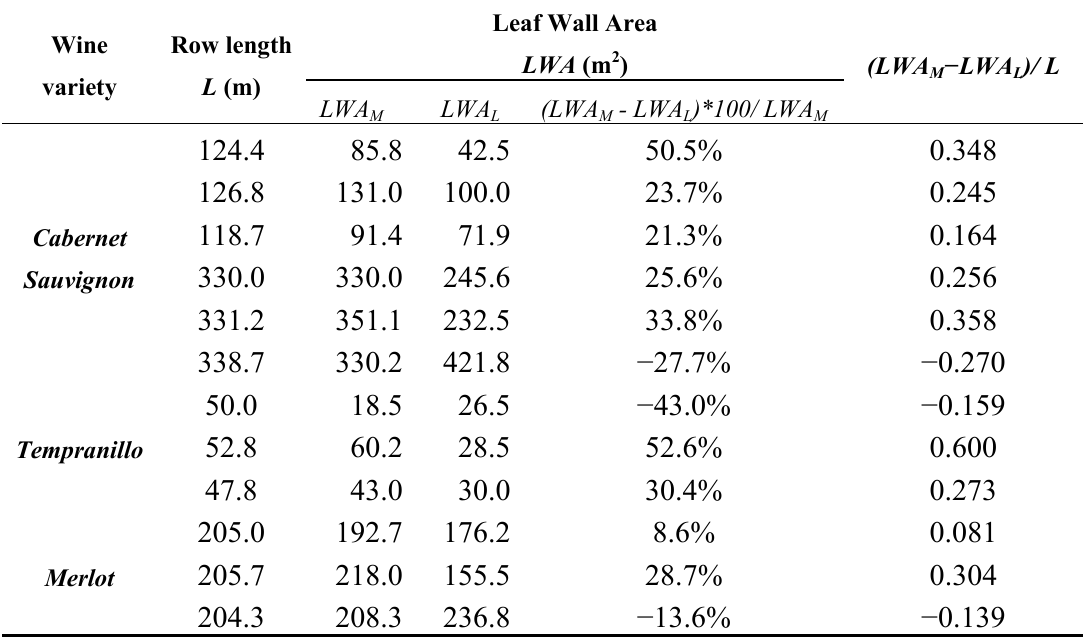
Table 3. Values of leaf wall area (LWA) for the whole row length (one side) manually measured and electronically estimated with LIDAR. Relative differences (%) and by row length unit